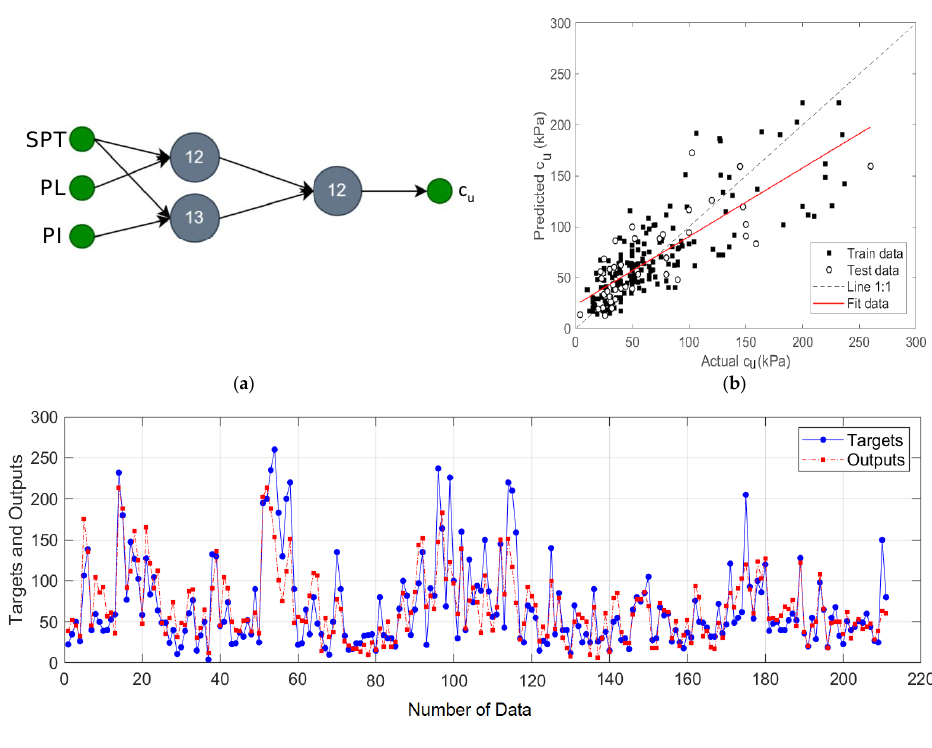
Figure 6. The proposed prediction model for input variables N SPT , PL , and PI : ( a ) two-layers GMDH- type NN structure; ( b ) regression plot; ( c ) target and output predictive values. The GMDH-type NN structure for the model was designed using σ v ’ , N SPT , LL, and PI input variables, and the results for this model are given in Figure 7. In the first layer of this network, neuron outputs for { σ v ’ , N SPT }, { N SPT , LL} and { N SPT , PI } input pairs were calculated and { σ v ’ , N SPT } output from these neurons was disabled because it increased the error rate. Then, the remaining neuron outputs are paired to generate the predicted output. The R 2 , MAE, and RMSE of this designed model are 0.82, 14.91, and 22.88, respectively.